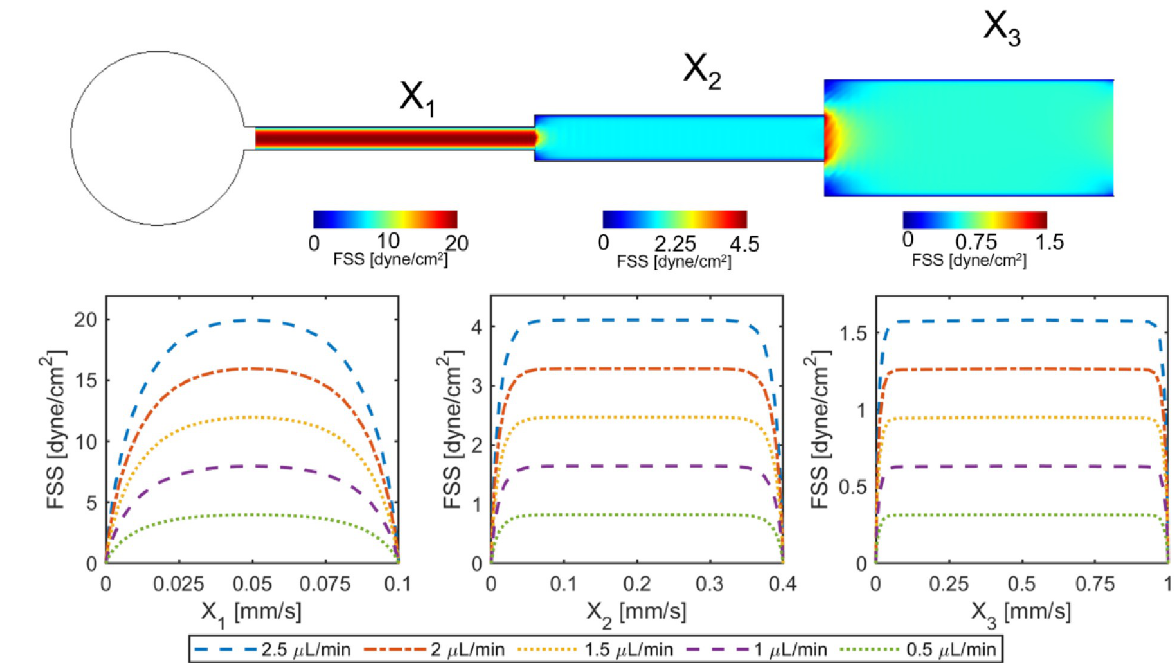
Fig 3. Characterization of FSS distribution on cultured biofilms for each of the three zones of the expanding chamber by computational fluid dynamic simulation. Except for a small fraction of the surface near the transitions between the zones, the FSS is uniform along the expanding chambers on the